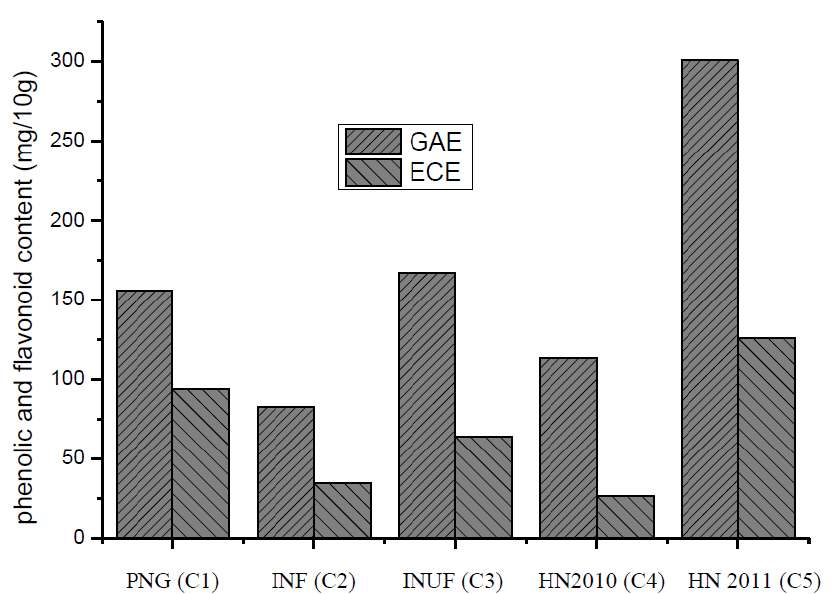
Figure 1. Total phenolic and flavonoid content of a cocoa bean, expressed as milligrams of gallic acid equivalents (GAE) and epicatechin equivalents (ECE) per 10.0 g,